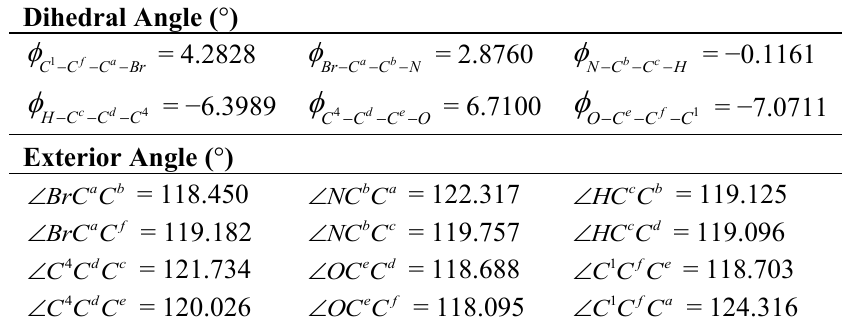
Table 1. The dihedral angles and six pairs of exterior angles on phenyl ring A 1 of (−)- 1 .